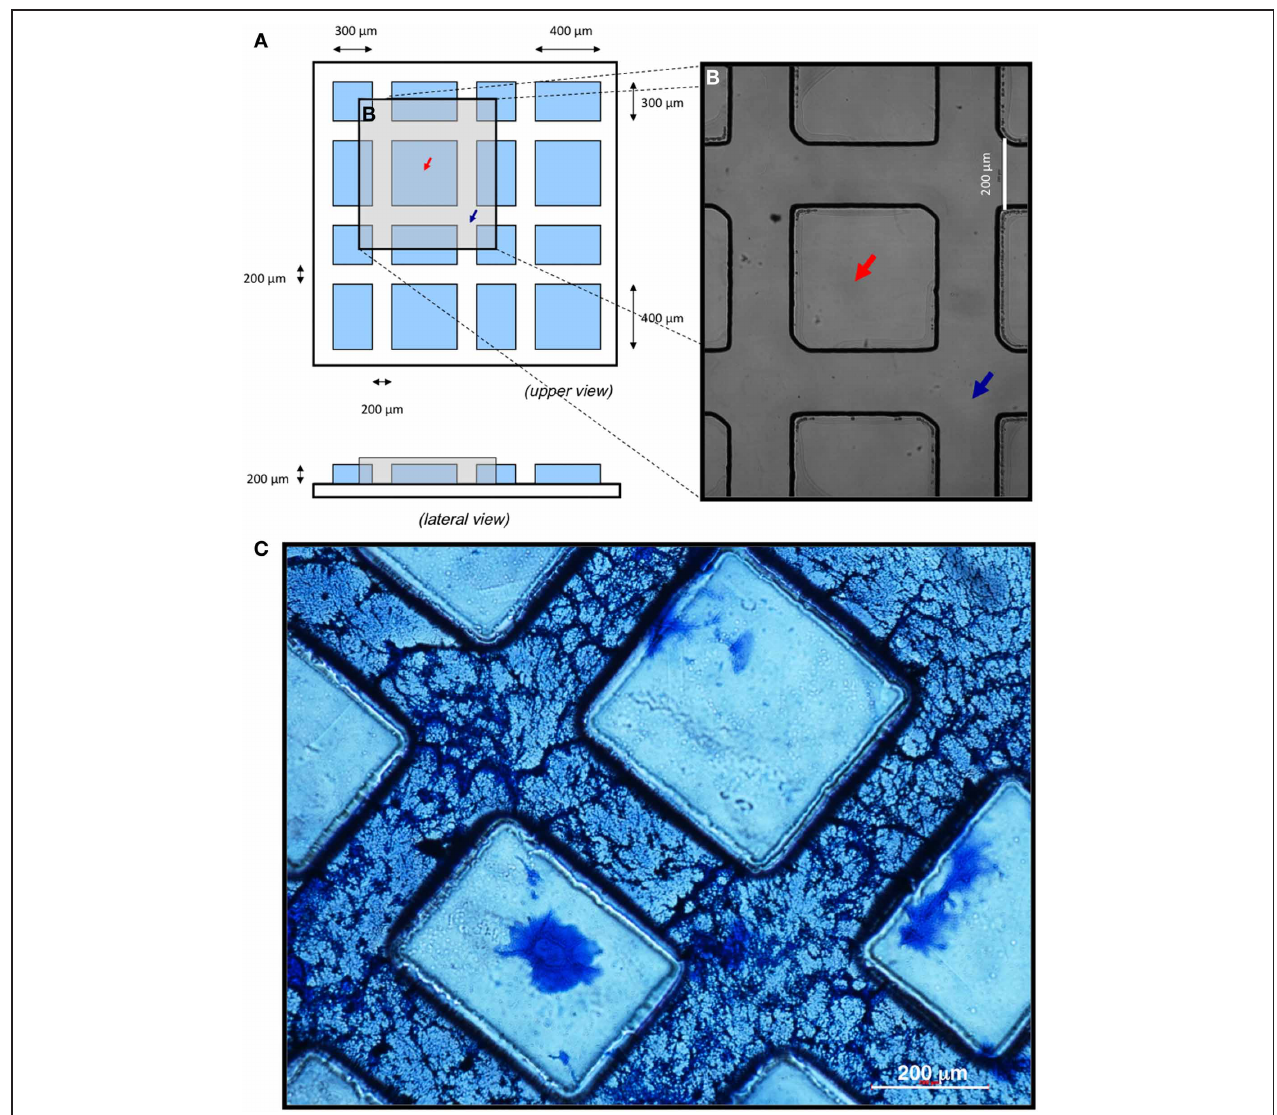
FIGURE 1 | Surface patterning of coverslips using photolithographic technique and coating with neural ECM. (A–B) Cartoon depicting the upper and lateral views of the micropatterned substrate (A) and optical microscopy image after conclusion of the photolithographic process, when “peaks” (red arrows) and “valleys” (blue arrows) were formed (B) .